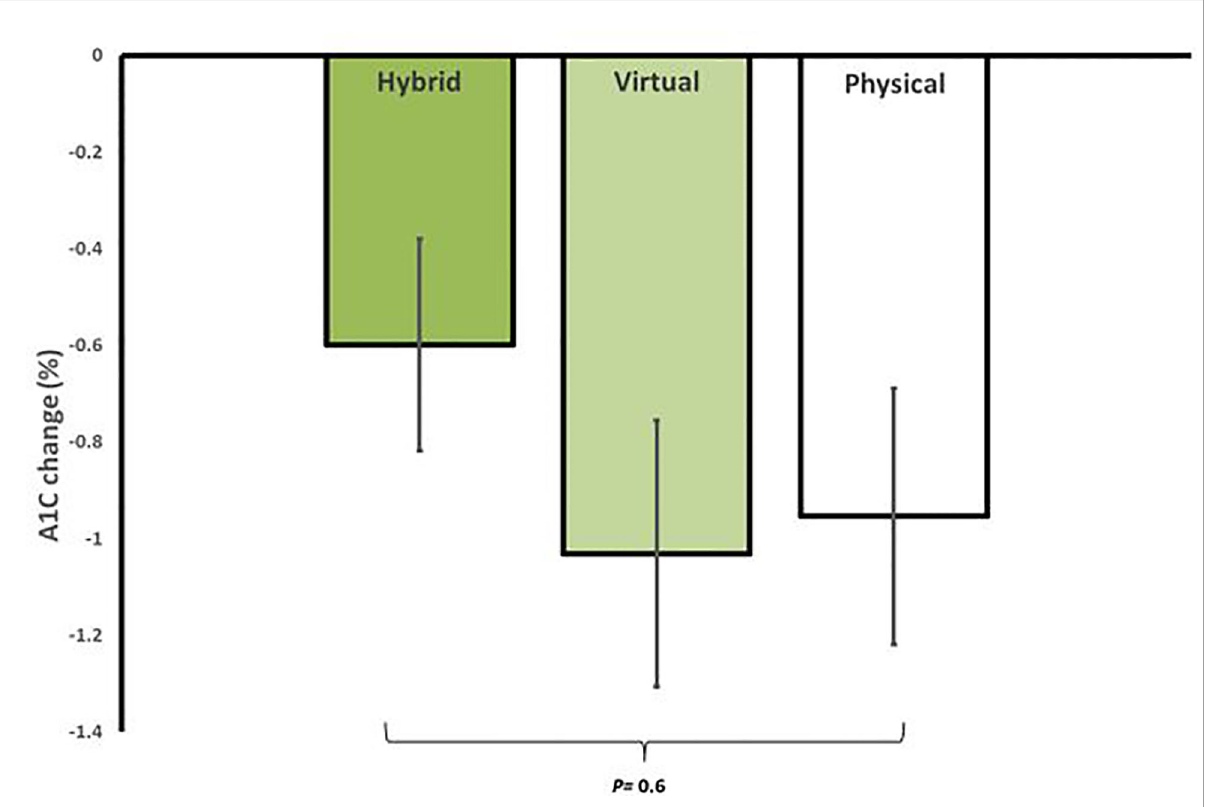
FIGURE 2 Average reduction in A1C for in-person (iPM), virtual (VM), and hybrid models (HM) after 12 weeks in a real-world intensive lifestyle intervention. All participants N = 56, iPM: n = 22, VM: n = 16, HM: n=18. p = change from baseline between iPM, VM, and